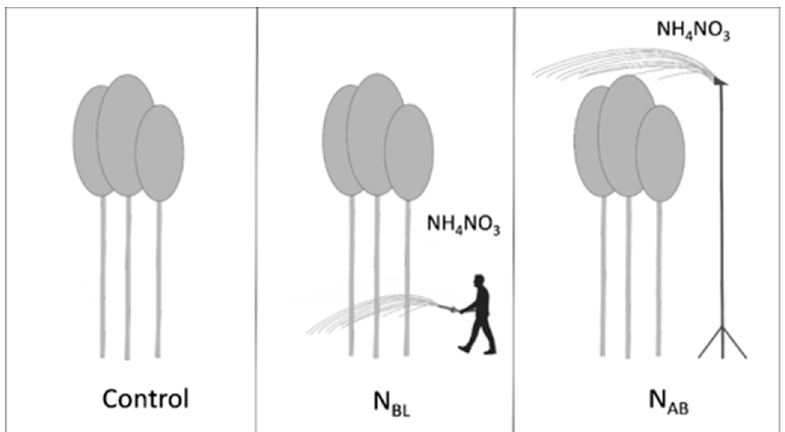
Figure 2. Illustrated scheme of the fertilization system adopted in this study. N BL = below canopy fertilization; N AB = above canopy fertilization; control = no fertilization.